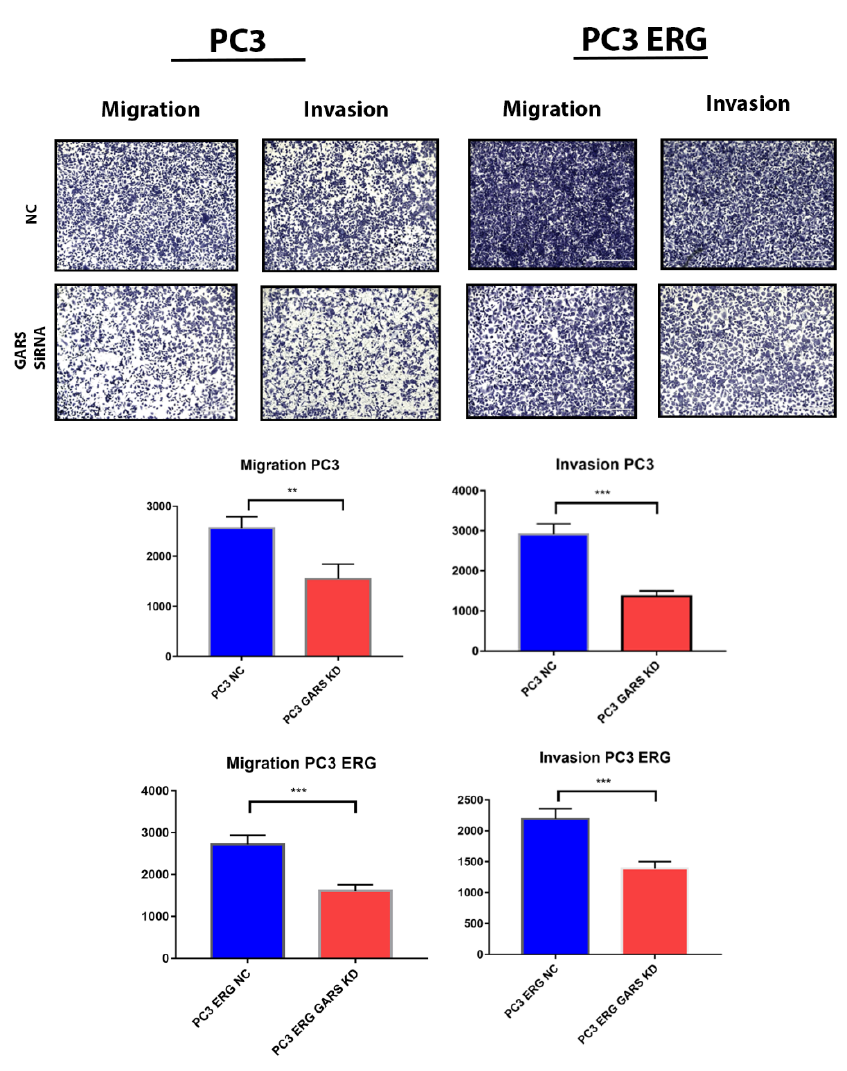
Figure 7. GARS knockdown reduced the ability of PC3 and PC3-ERG cells to migrate and invade in vitro analyzed over 3 replicates (Asterisk *** indicates p < 0.001 and ** indicates p < 0.01). Scale bar in the figure represents 400 μ m.